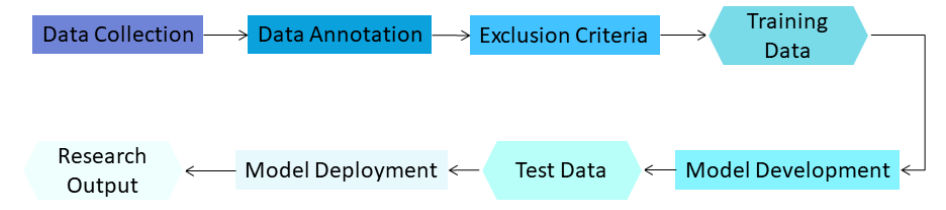
Figure 2. Phases of AI model development in medical